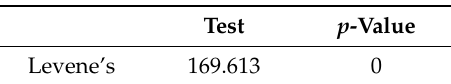
Table 2. Levene’s test.